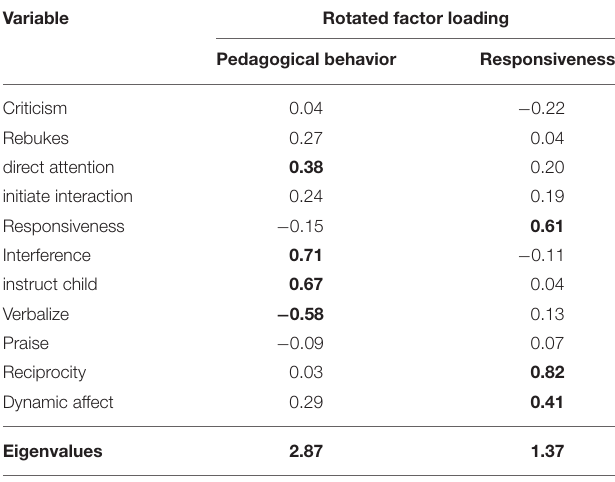
TABLE 2 | Factor analysis on maternal behavior